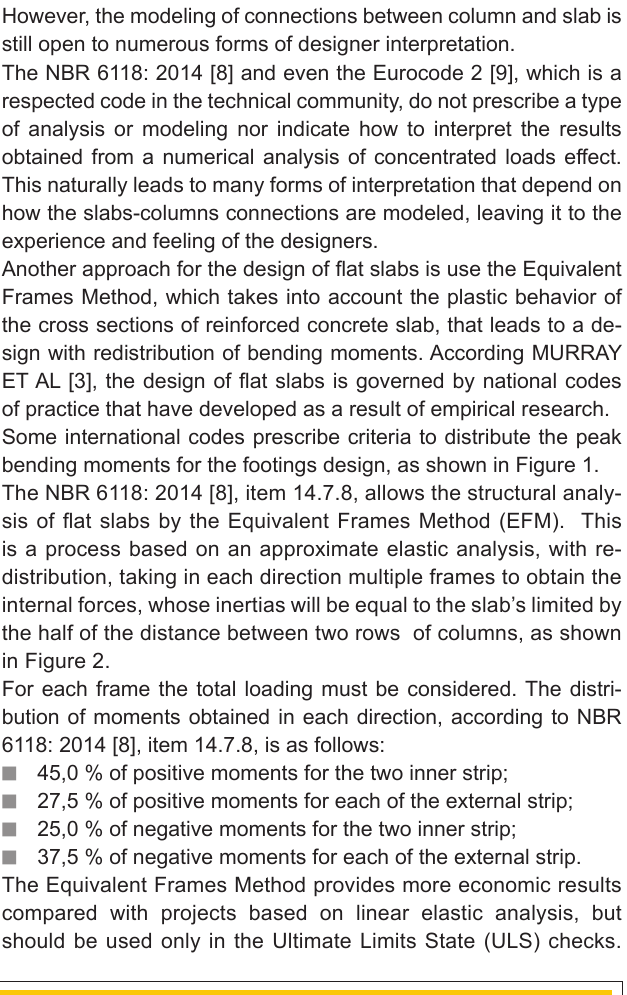
Figure 2 – Strip distribution of bending moments according NBR 6118:2014